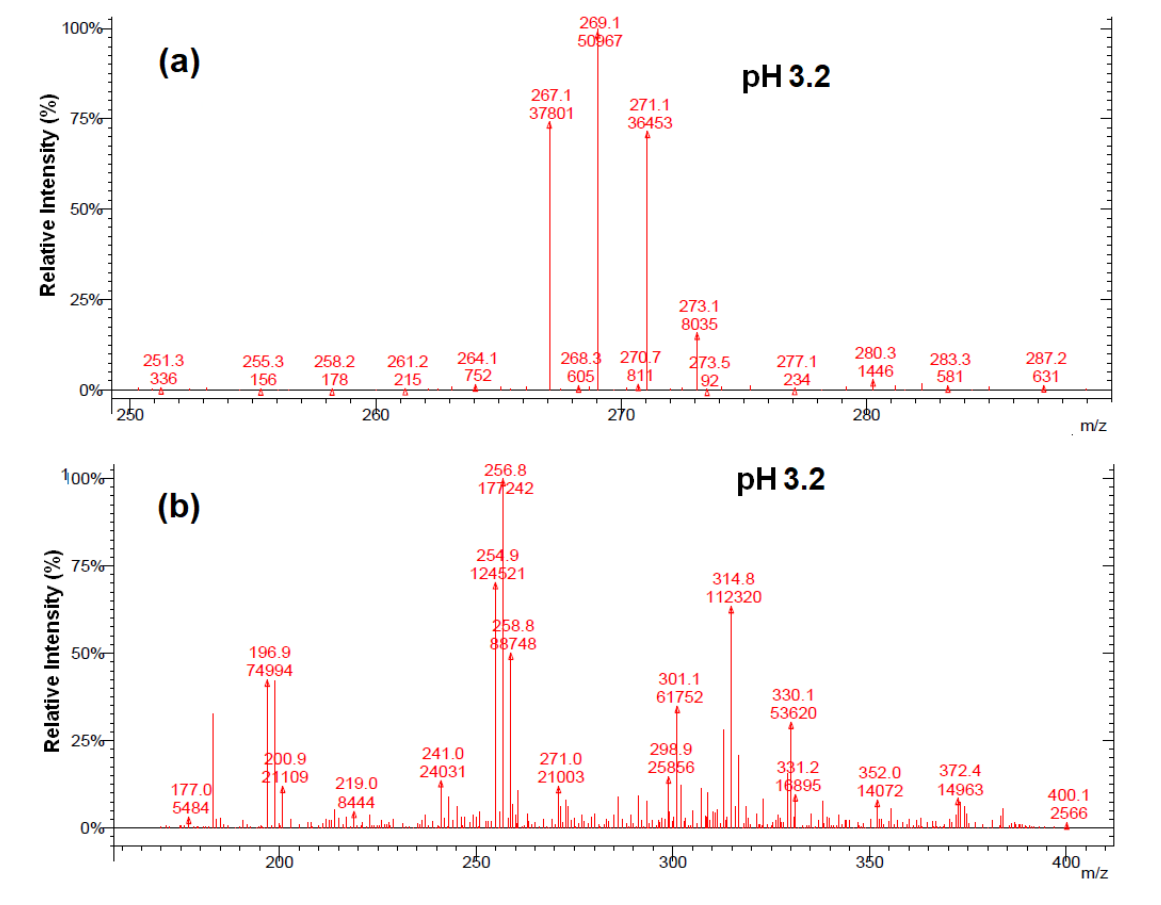
Fig. S4. (a) Negative-ion ESI–MS spectrum for the complexes formed in the FeCl /PicHA system at ligand-to-metal molar ratio 4:1, pH 3.2, C 3 L -1 . Explanation of the signal described in the text: m/z = 269.0 [Fe(II) + fragment ion m/z = 122 + NaOH + 3OH] - . (b) Positive-ion ESI–MS spectrum for the complexes formed in the FeCl system at ligand-to-metal molar ratio 4:1, pH 3.2, C Explanation of the signals described in the text: m/z = 197.0 [Fe(II) + fragment ion m/z = 106+Cl] + m/z = 255.0 [Fe(II) + fragment ion m/z = 106 + NaCl + Cl] +